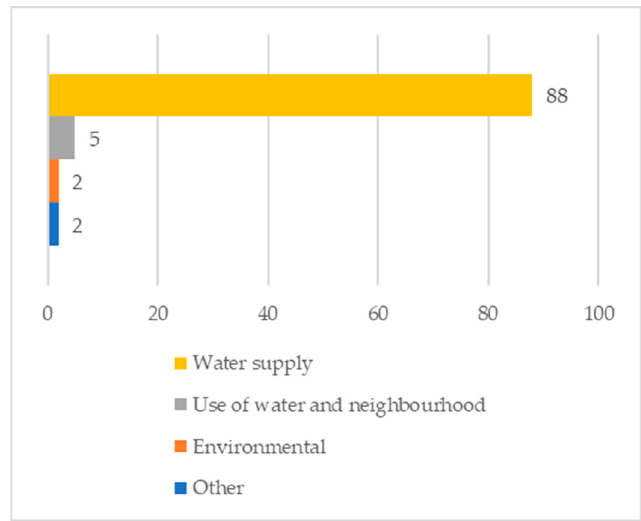
Figure 4. Decisions’ topic.